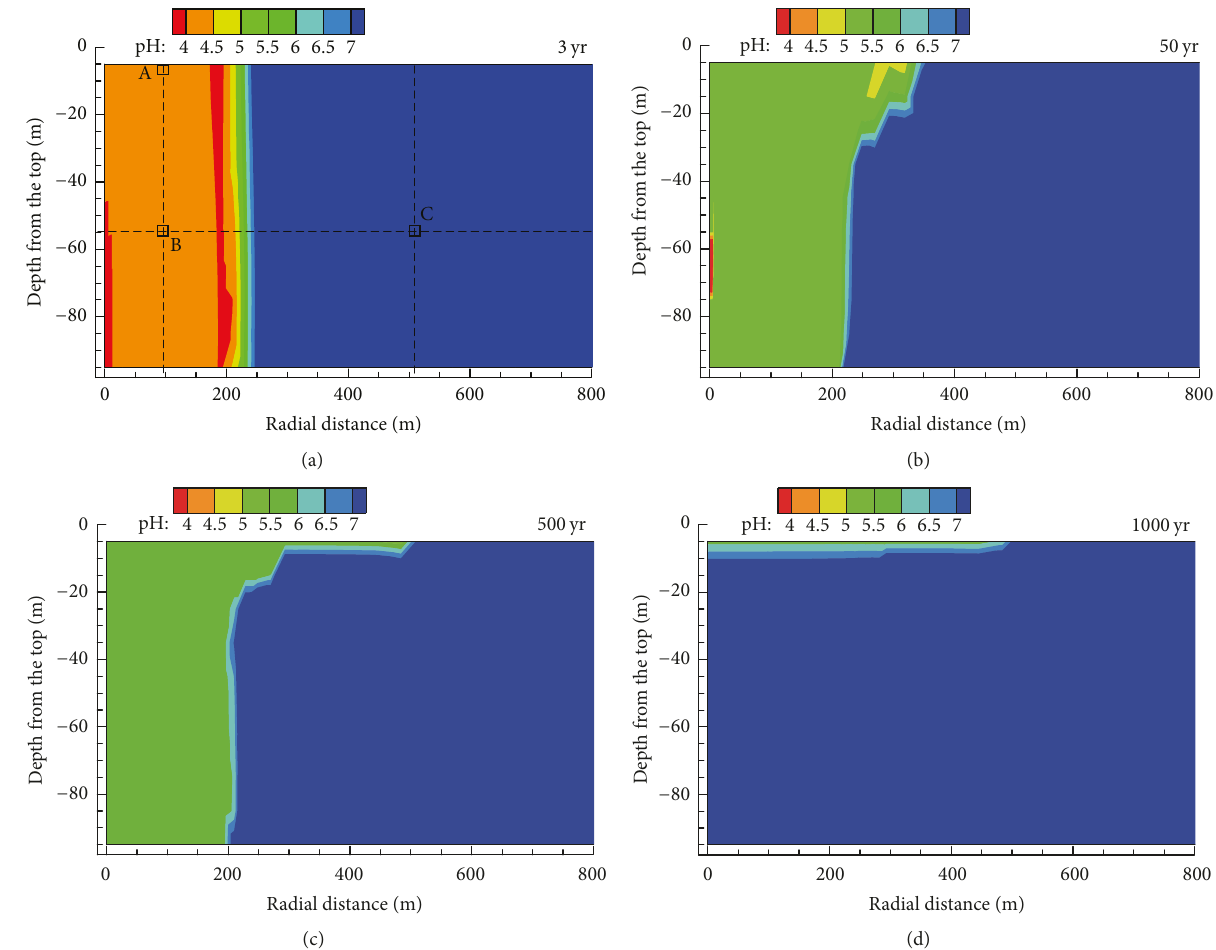
Figure 5: The pH spatial distribution of the Liujiagou formation at different